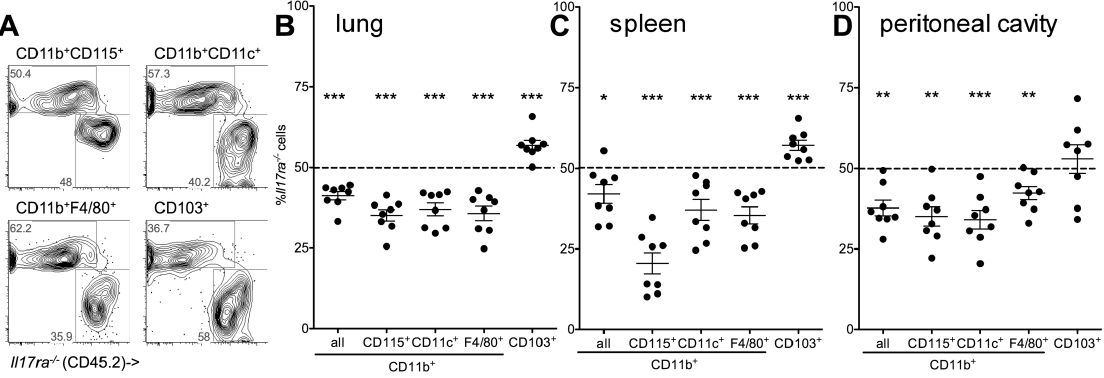
Figure 4. Homeostatic tissue macrophages are altered without IL-17 receptor. ( A–D ) Monocytes, macrophages and dendritic cells from mixed bone marrow chimeric wt/ Il17ra -/- mice were analyzed by flow cytometry after enzymatic digestion of lungs (examples in A, statistical analysis in B), in spleen (C) and peritoneal cavity (D) (n=8 and 2 independent transplantations, paired t-tests).